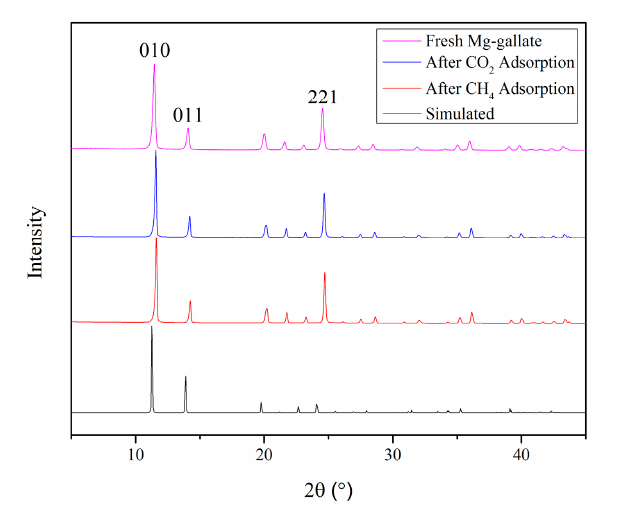
Figure 2. PXRD pa tt erns of Mg-gallate. Figure 2. PXRD patterns of